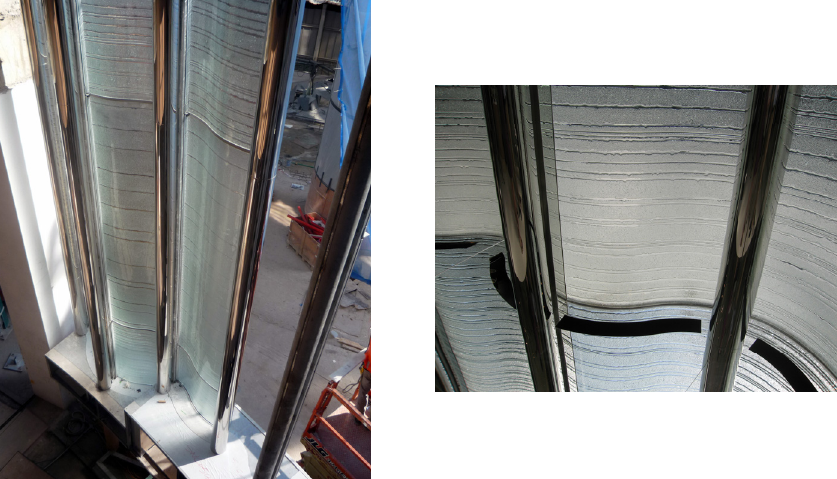
Figure 25a, b: Completed Façade Interior, Interior